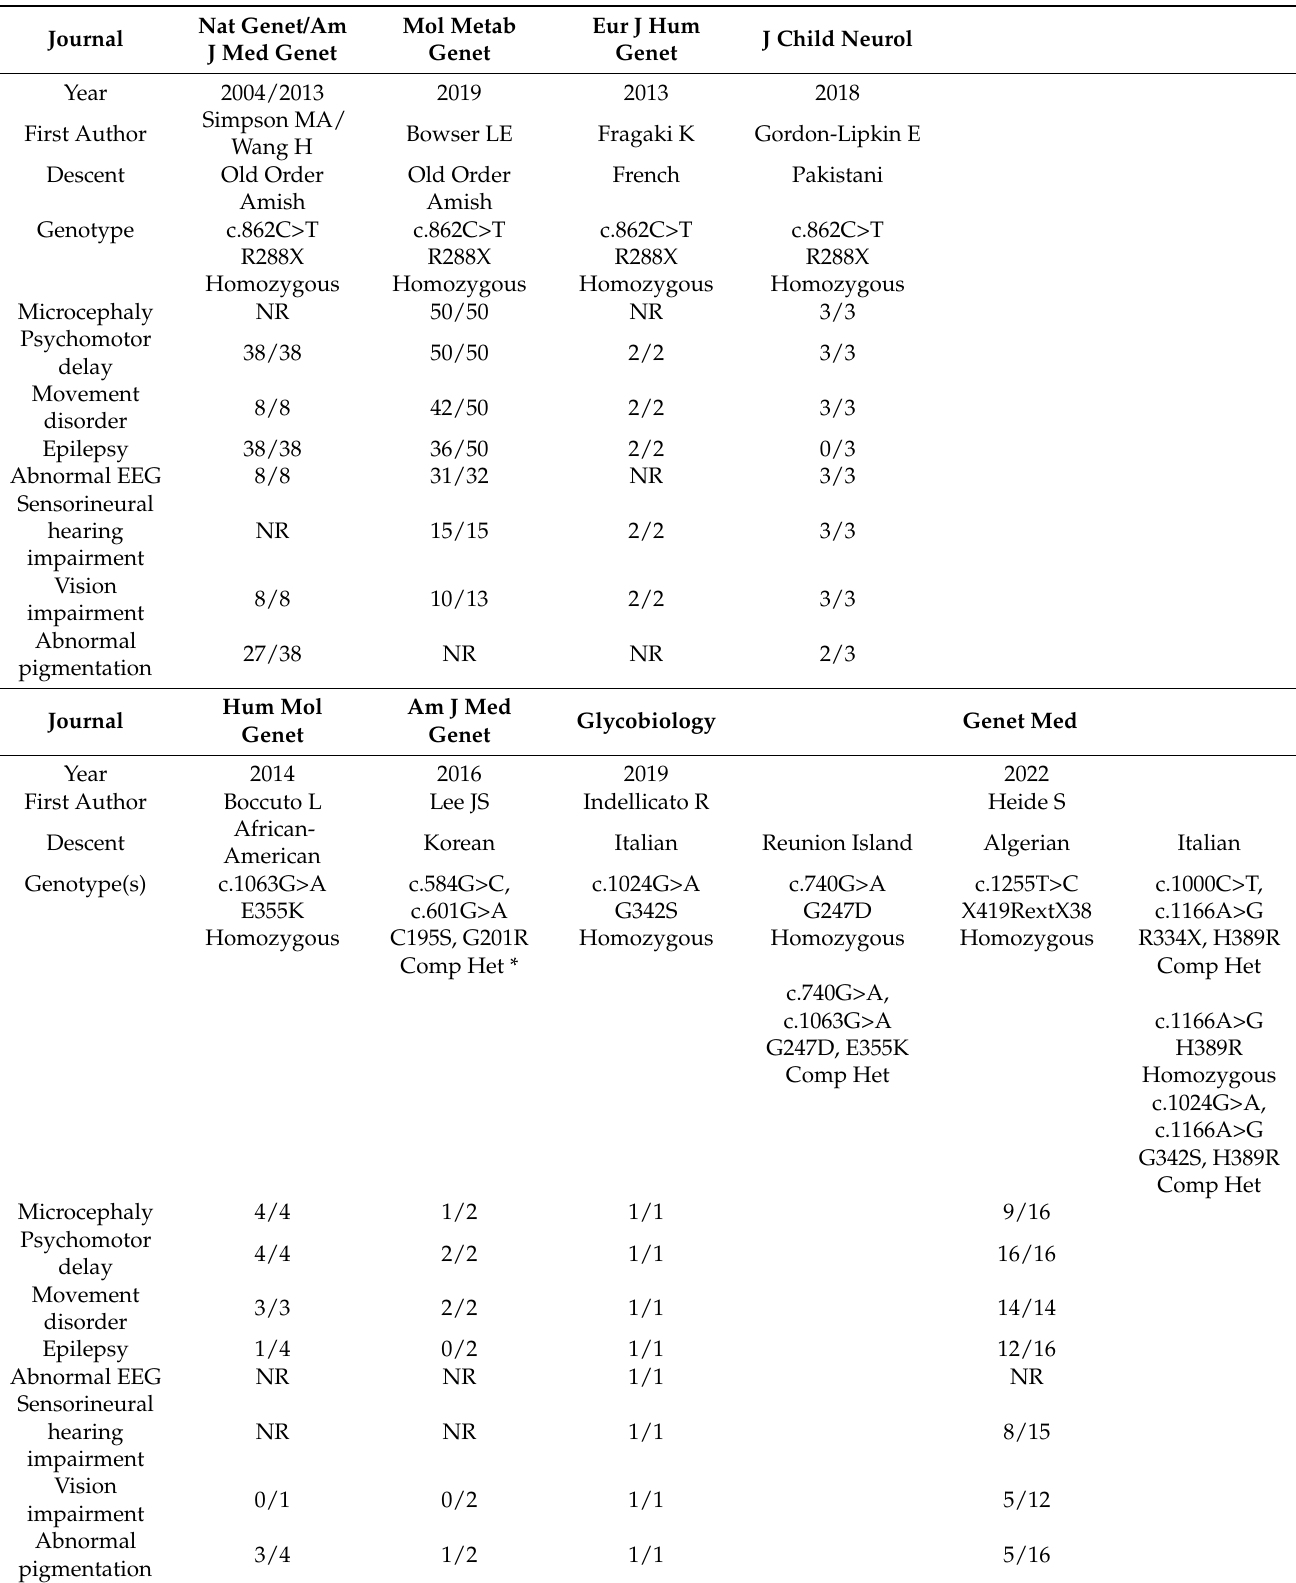
Table 1. Clinical Features of patients with GM3 Synthase